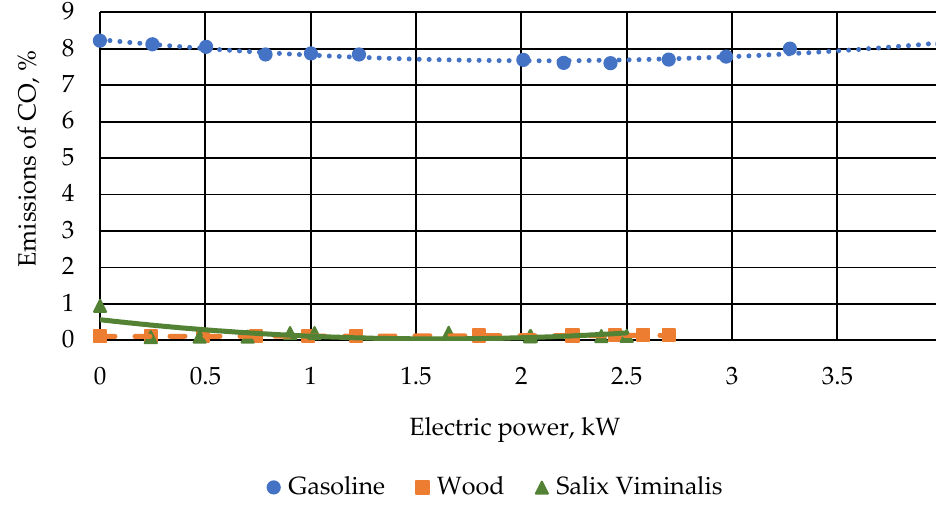
Figure 8. Fuel consumption.